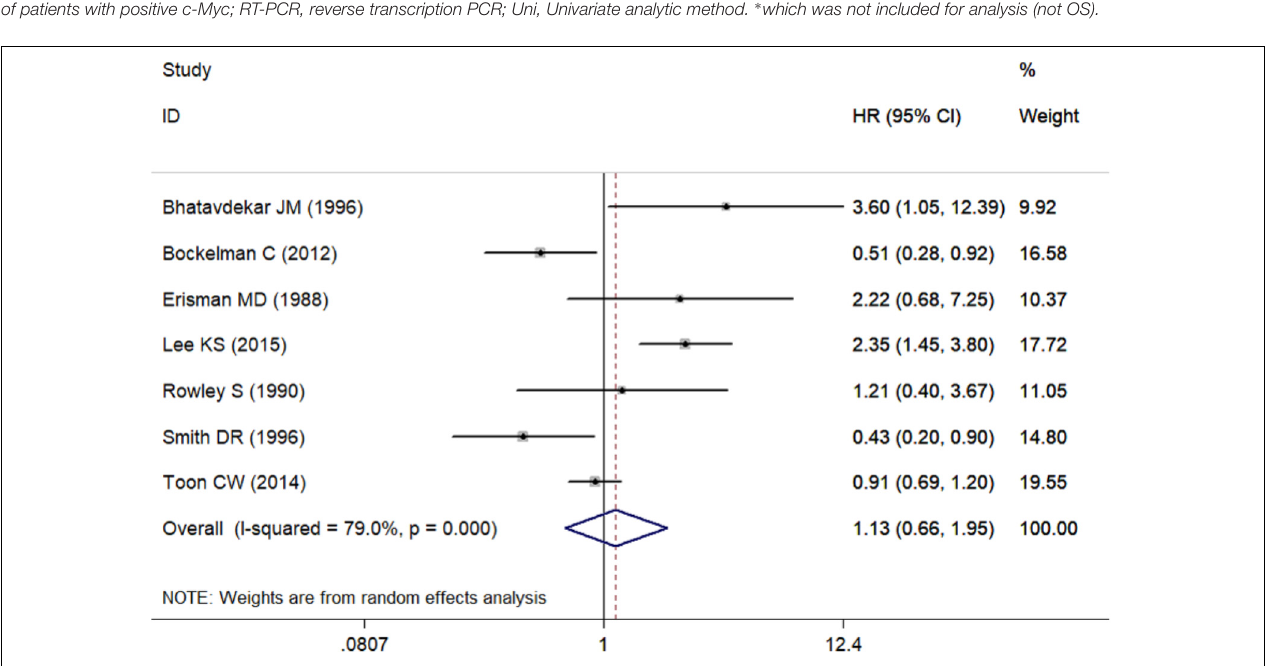
FIGURE 2 | The association between c-Myc and overall survival in seven